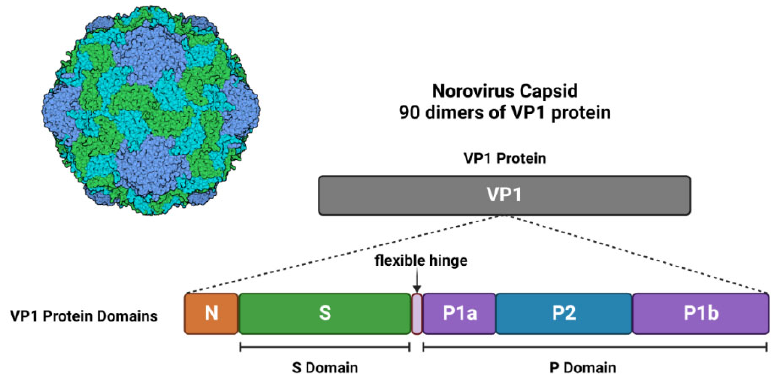
Figure 2. NoV Viral Particle Structure. NoV capsid is formed of 180 VP1 proteins assembled into 90 dimers. The P2 domain of VP1 is the most surface exposed part of the capsid and is highly variable. This interface is thought to be the one which interacts with HBGAs. Made using Biorender.com accessed on 18 October 2022 . Table 1. NoV Open reading frames, genes and proteins associated with viral survival and structure.